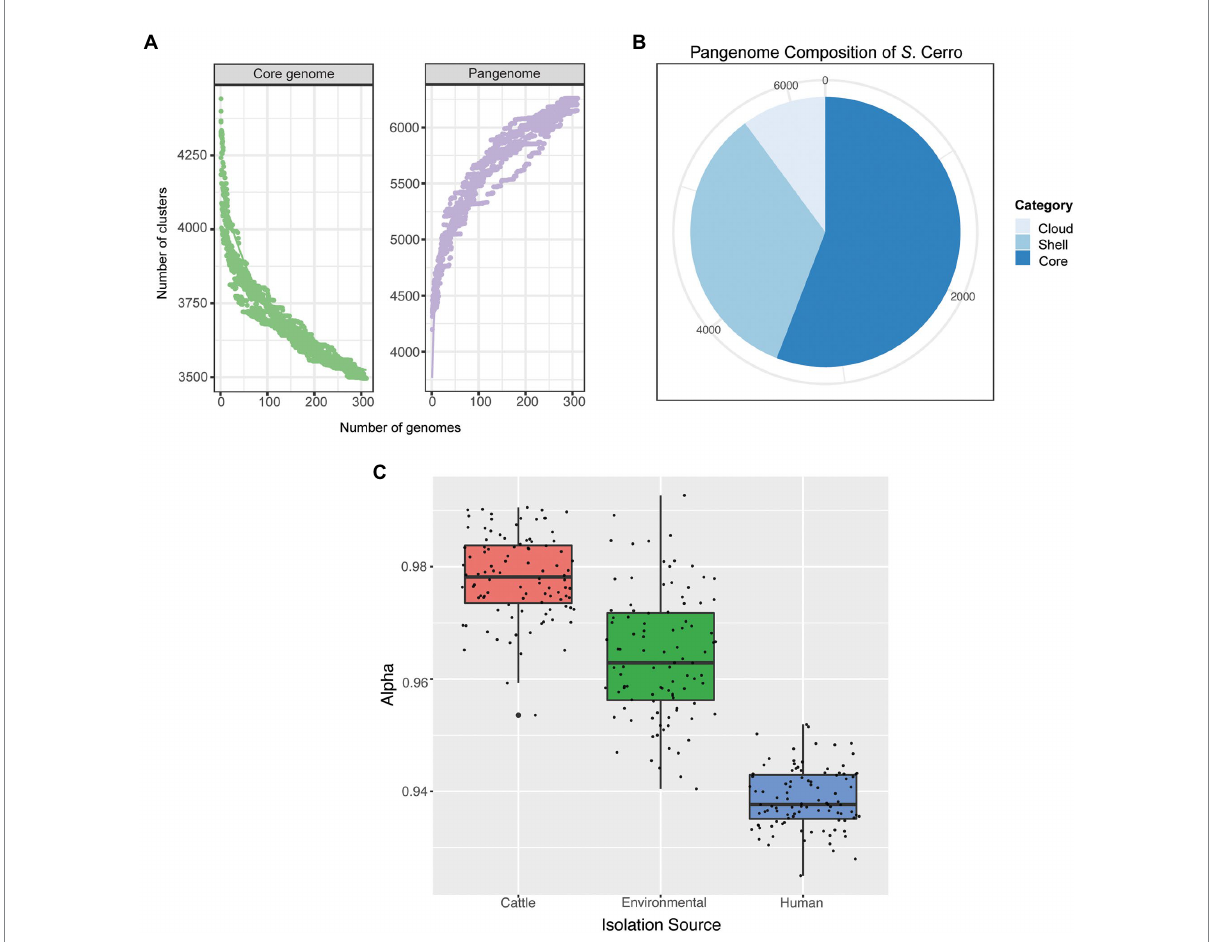
FIGURE 3 Section Typhi S. Cerro isolates have an open pangenome, which differs based on isolation source. (A) Rarefaction curves of the core and pangenome of S. Cerro. (B) Pie chart of the pangenome composition of S. Cerro as determined with Panaroo (Tonkin-Hill et al., 2020). Core genes are those detected in 100% of isolates included in this study, shell genes are detected in 15–99% of isolates, and cloud genes are detected in <15% of isolates. (C) A boxplot of alpha values of calculated Power Law Models from permutations of 15 isolates per isolation source.